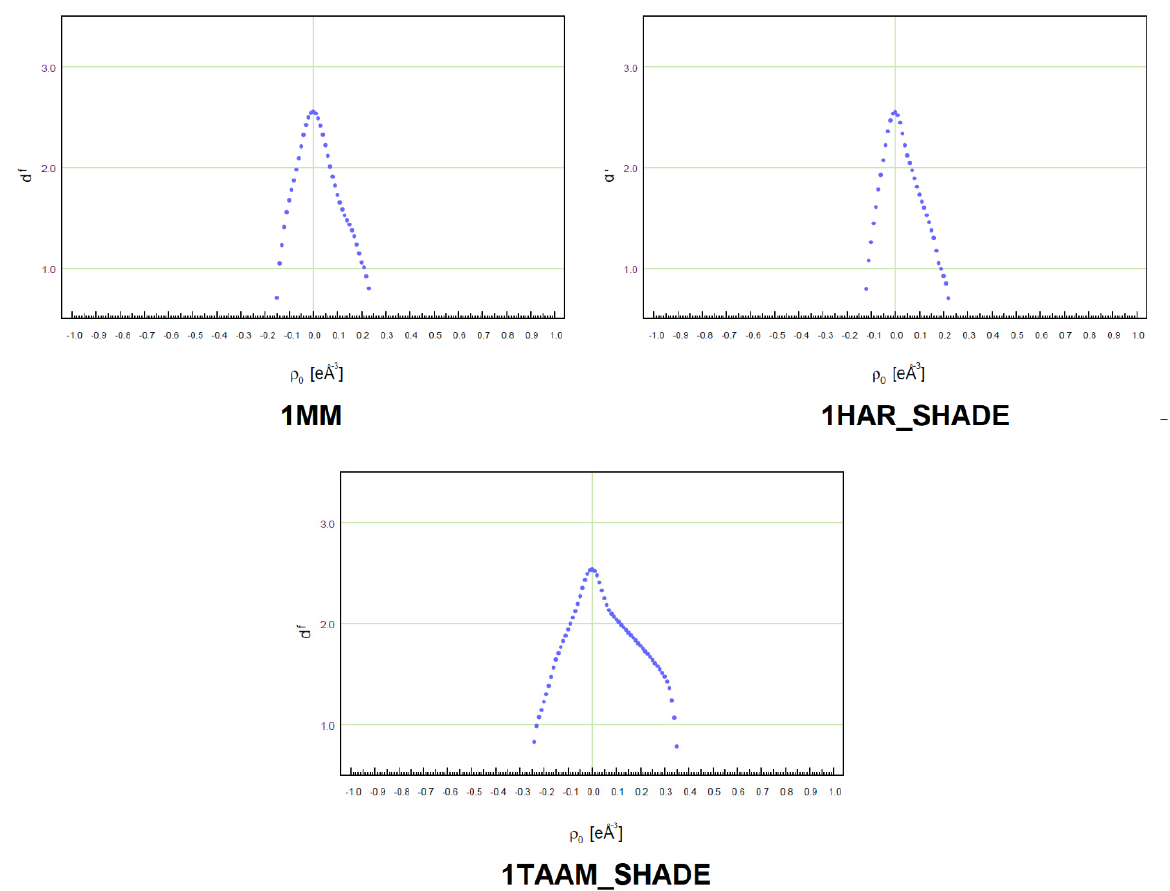
Figure 4. Fractal dimension plots for MM, HAR_SHADE, and TAAM_SHADE refinements of 1 . Fractal dimension plots for all analysed compounds and methods are available in the Supplementary Materials (Figures S5–S7).